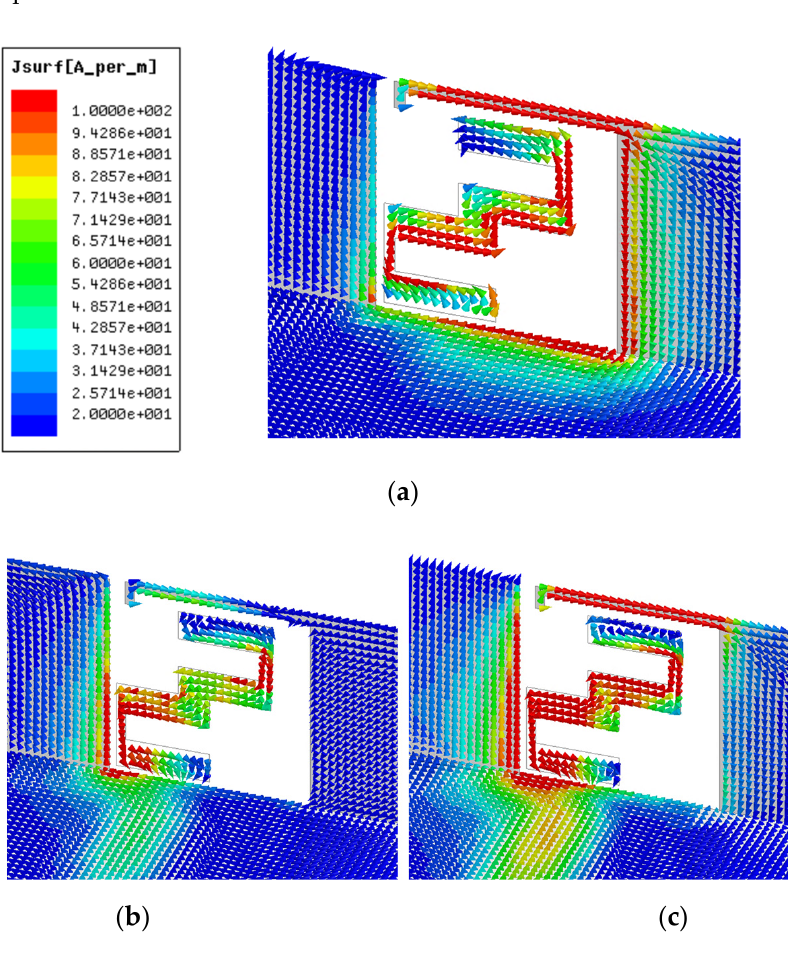
Figure 2. Design evolution of antenna element: ( a ) The evolution shapes; ( b ) The reflection coeffi- cient.